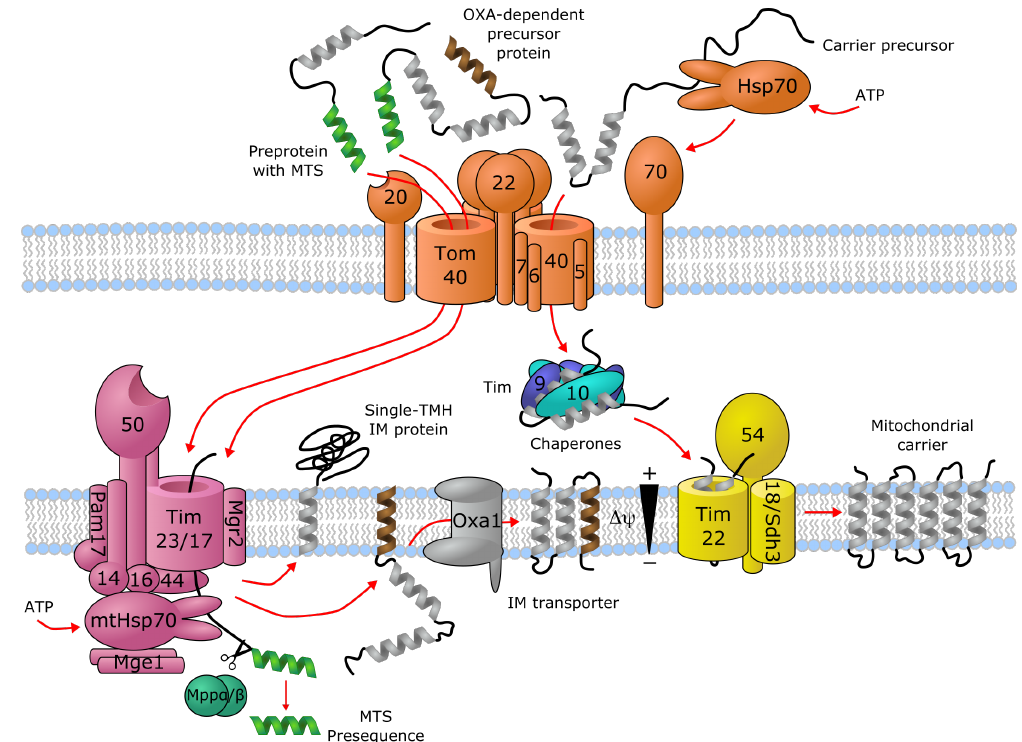
Figure 1. Import machinery for mitochondrial transporters. The TOM (orange), TIM23 (purple) and TIM22 (yellow) complexes are depicted, with numbers representing the corresponding Tom/Tim protein names. Proteins with a single transmembrane helix (TMH) and OXA-dependent transporters employ the TIM23 import pathway, while carriers with no mitochondrial targeting sequence (MTS)